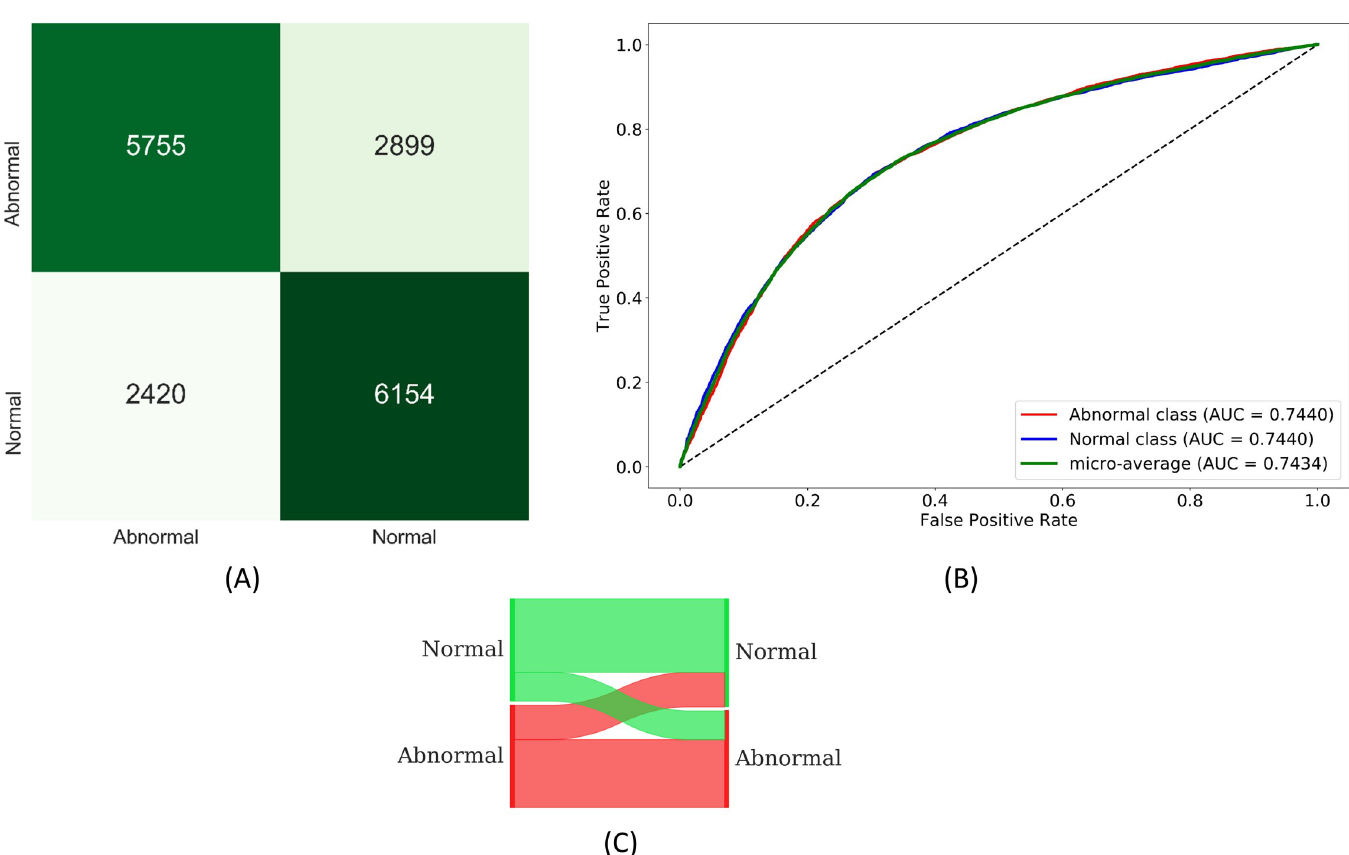
Fig 9. Performance achieved using the VGG-19 model during the first-stage of CXR-specific pretraining. (A) Confusion matrix; (B) ROC curves; (C) Normalized Sankey flow diagram. https://doi.org/10.1371/journal.pone.0242301.g009 models. The confusion matrix, ROC curves, and normalized Sankey flow diagram obtained using the VGG-19 model toward this classification task are shown in Fig 9. We used a normal- ized Sankey diagram [48] to visualize model performance. Here, weights are assigned to the classes on the truth (left) and prediction (right) side of the diagram to provide an equal visual